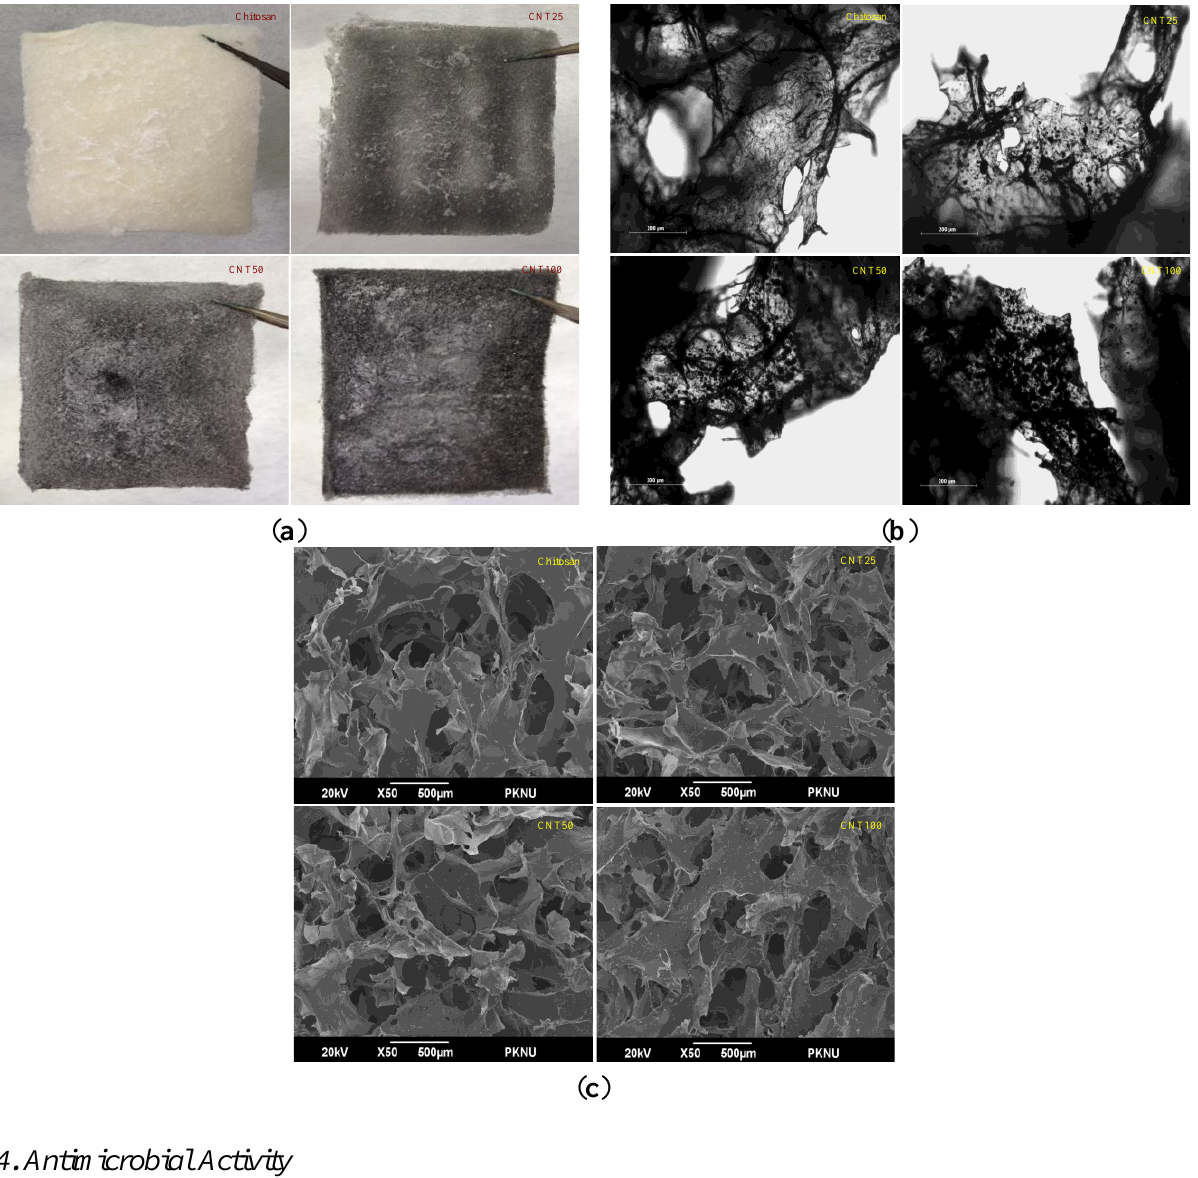
Figure 4. ( a ) Normal photograph images of CH, CNT25, CNT50 and CNT100. Sample size is 7 cm × 7cm, length and breadth; ( b ) Optical microscopic images of CH, CNT25, CNT50 and CNT100. Scale bar is 200 μm; ( c ) Scanning electron micrograph of CH, CNT25, CNT50 and CNT100. Scale bar is 500